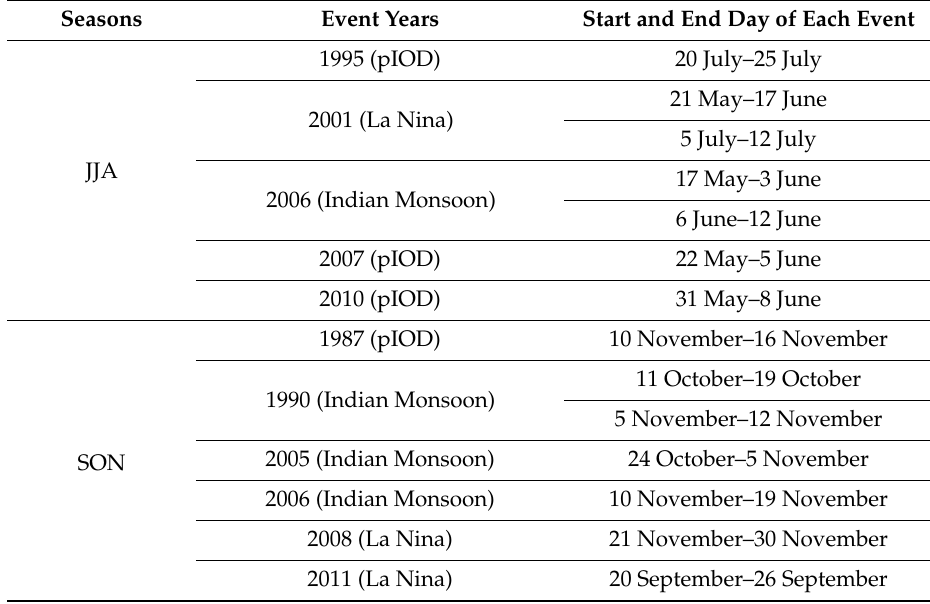
Table 4. The extreme high streamflow events at Kesinga station for JJA and SON seasons, where each event is selected from the persistence occurrence of high flows for 6 days or more (1980–2013).